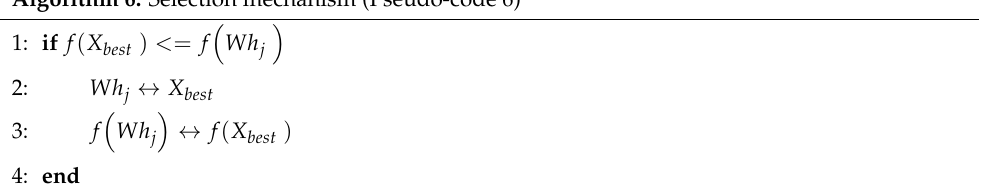
Algorithm 6. Selection mechanism (Pseudo-code